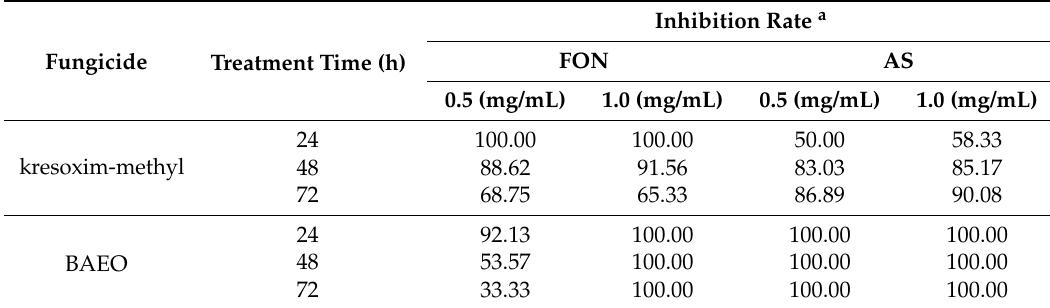
Table 5. The effect of treatment time on the antifungal activity of BAEO against Fusarium oxysporum f. sp. niveum and Alternaria solani